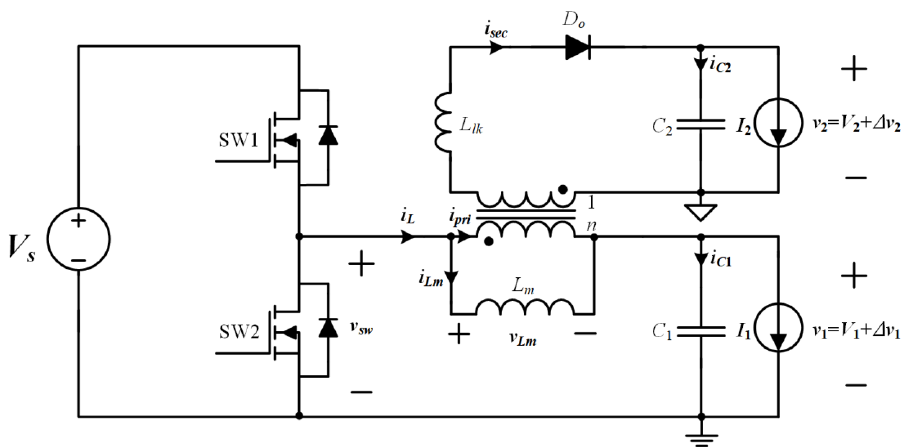
Figure 1. Circuit diagram of the fly-buck converter [9–13].